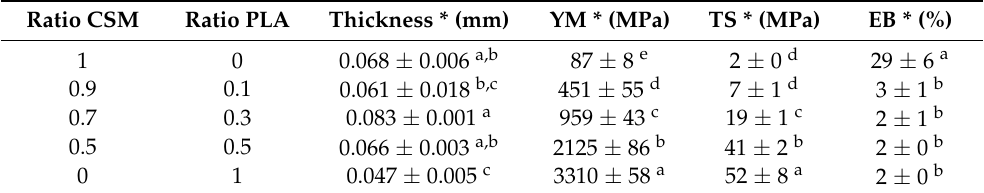
Table 1. The five film samples showed thickness values in the range of 0.047–0.083 mm. Table 1. Bilayer films of CSM and PLA: thickness, Young’s modulus (YM), tensile strength (TS), and elongation at break